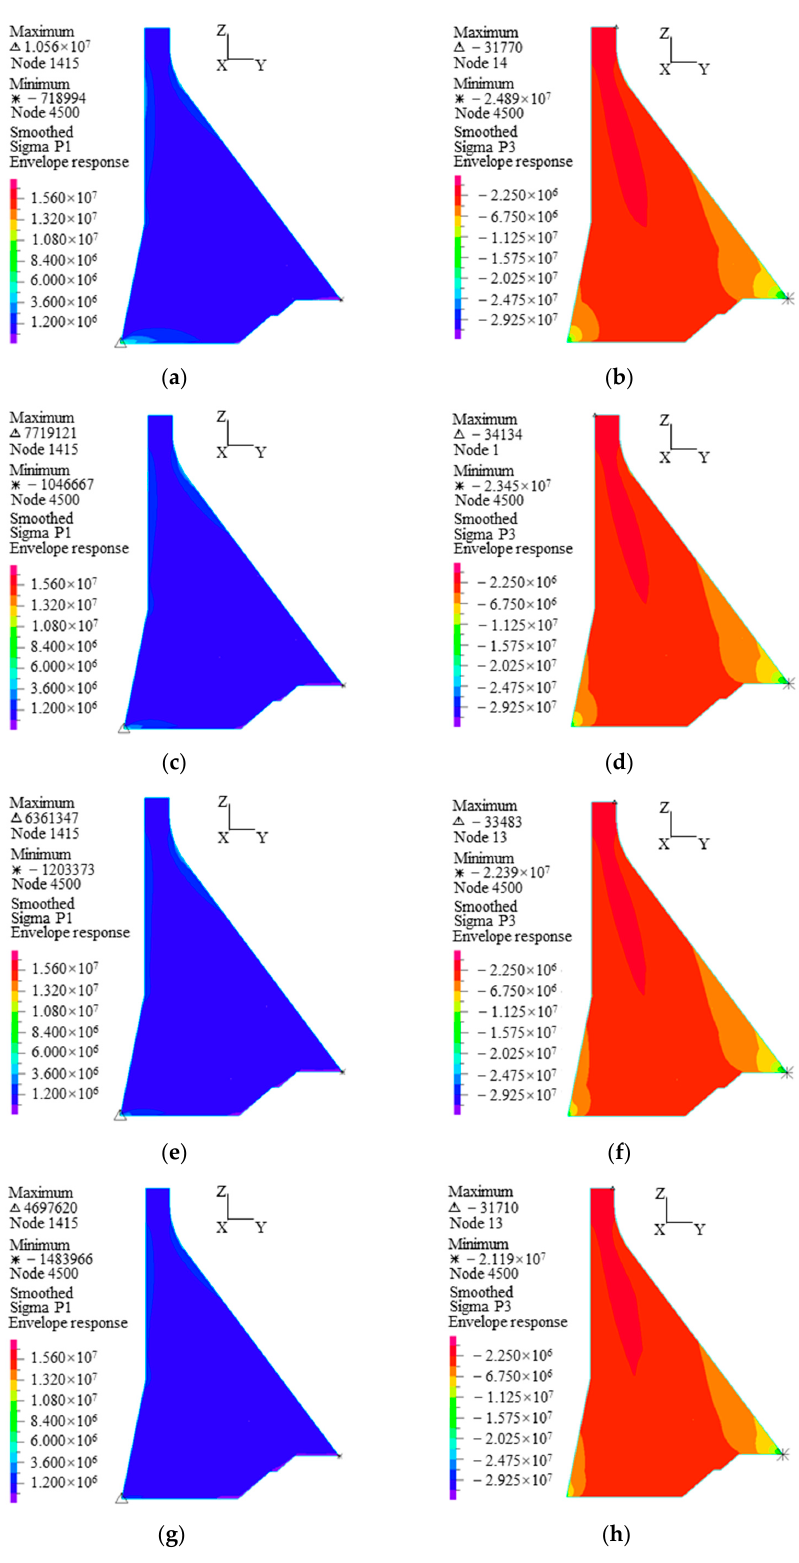
Figure 13. The principal stress envelopes of the dam for different foundation sizes obtained using the VABF model (Pa). ( a ) The distribution of σ 1 for C-1 (1H), ( b ) the distribution of σ 3 for C-1 (1H), ( c ) the distribution of σ 1 for C-2 (1.5H), ( d ) the distribution of σ 3 for C-2 (1.5H), ( e ) the distribution of σ 1 for C-3 (2H), ( f ) the distribution of σ 3 for C-3 (2H), ( g ) The distribution of σ 1 for C-4 (3H), ( h ) the distribution of σ 3 for C-4 (3H).